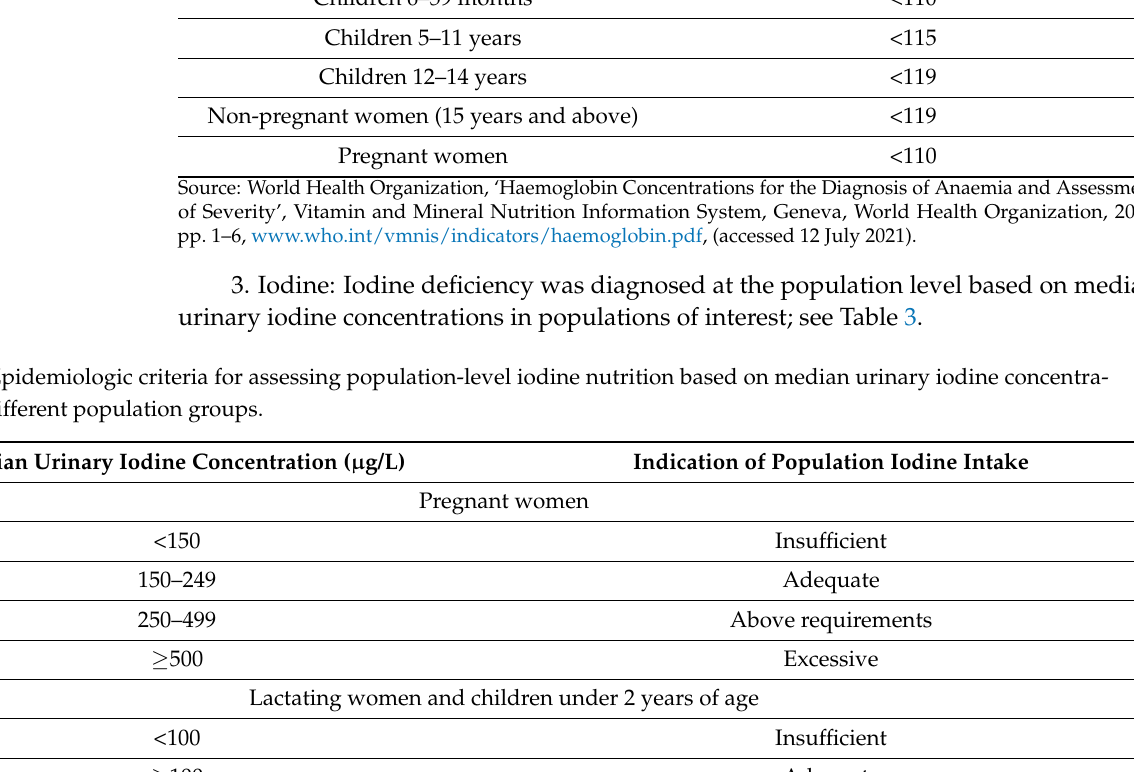
Table 2. Hemoglobin levels to diagnose anemia at sea level (g/L). Population